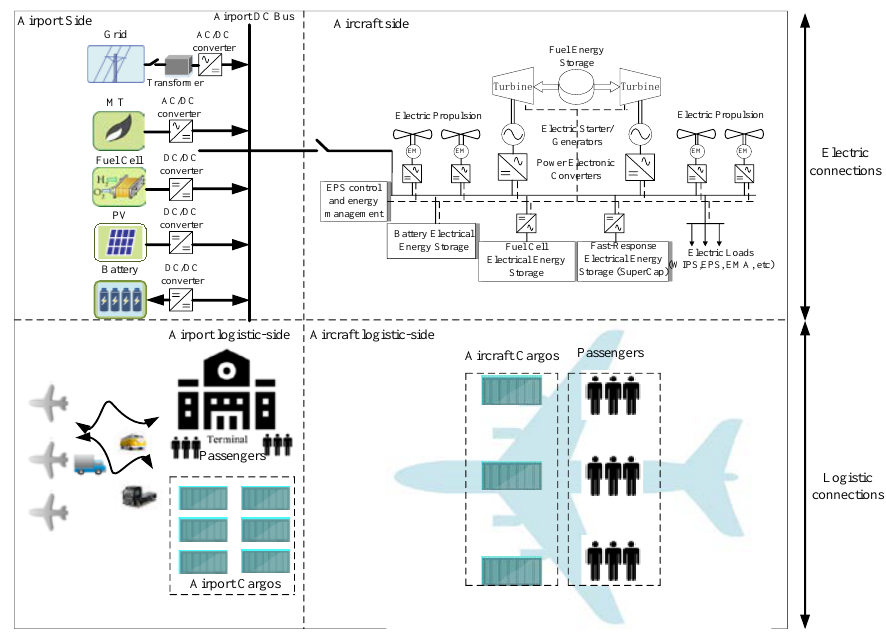
Figure 19. The energy and power interaction between the airport microgrid and electric aircraft.